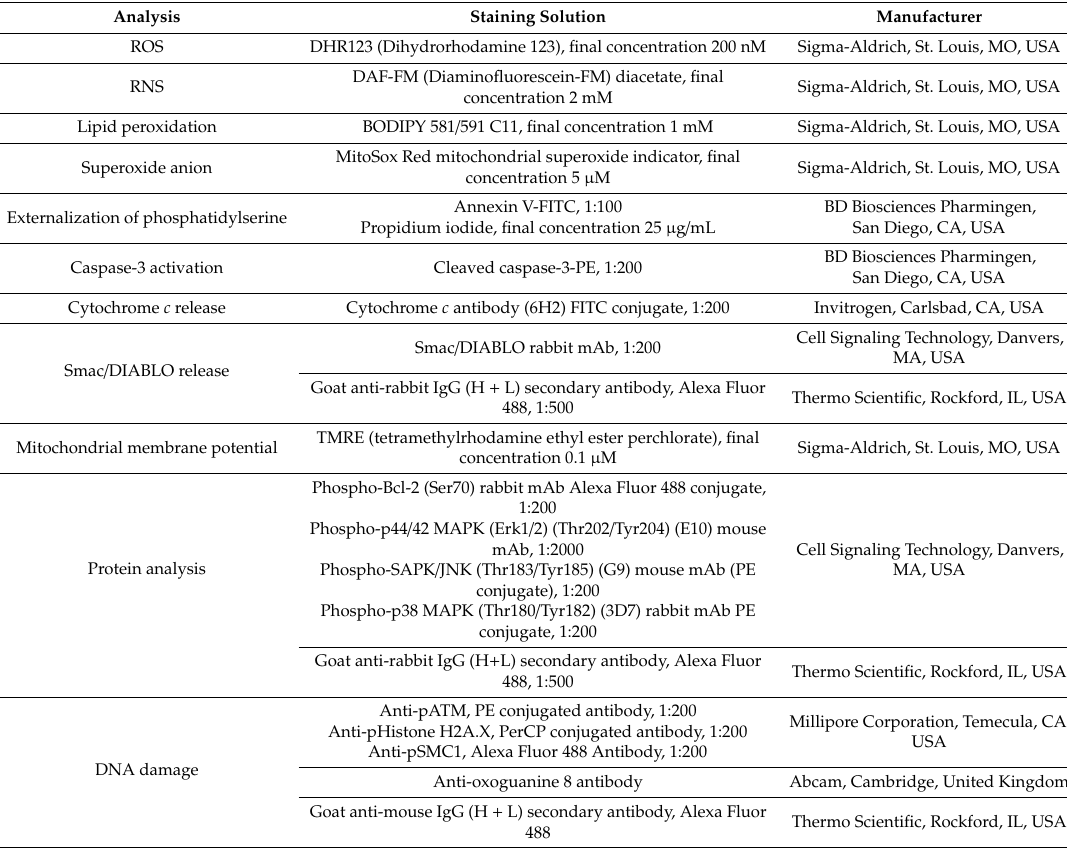
Table 1. Flow cytometry